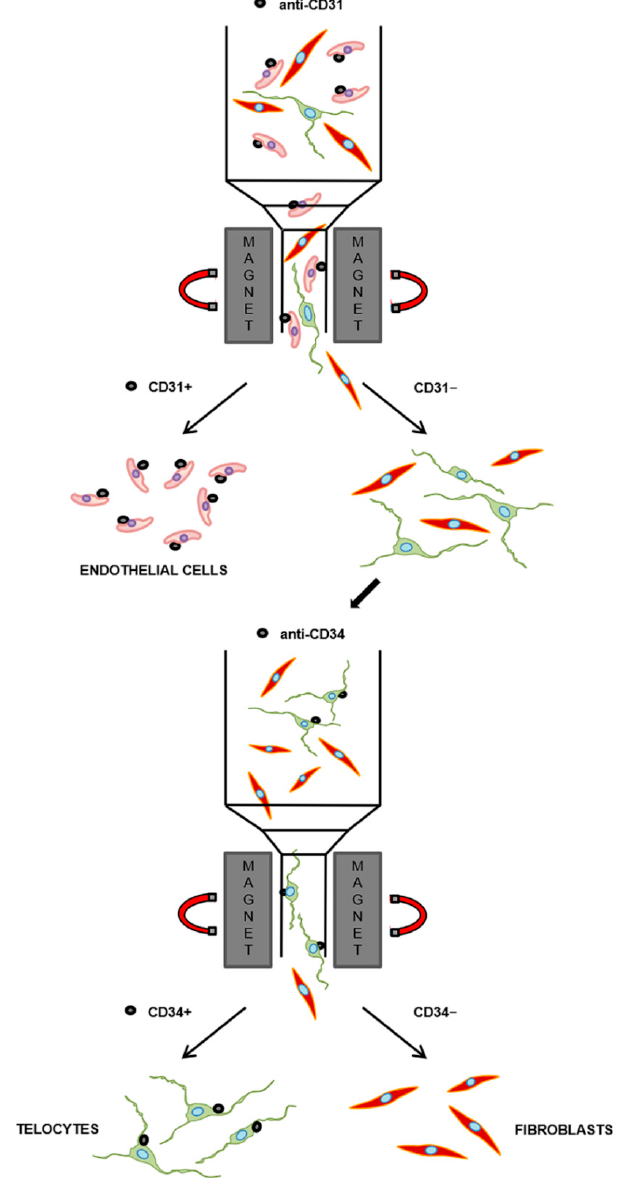
Figure 1. Schematic representation of the two-step immunomagnetic microbead-based cell separation protocol. Total dermal cells obtained from the processing of healthy human skin samples were subjected to magnetic-activated cell sorting separation. The first step was carried out in order to isolate CD31+ cells (i.e., putative endothelial cells), while the second step, performed on the pool of the remaining CD31 − cells, allowed the further separation of CD31 − /CD34+ cells (i.e., putative telocytes) from CD31 − /CD34 − cells (i.e., putative fibroblasts).